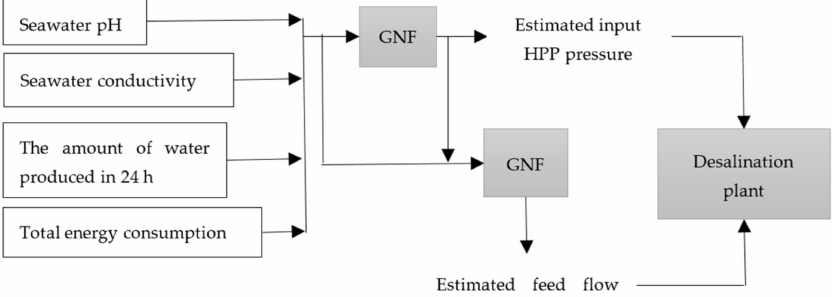
Figure 5. Diagram of inputs and outputs to Genetic